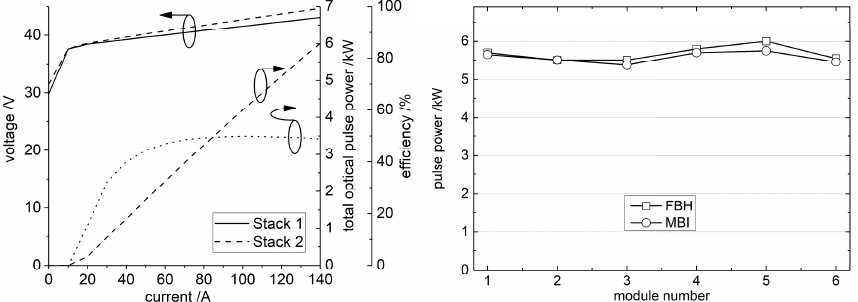
Figure 1. Left : Bias voltage (for the two stacks in a module), optical power and power conversion efficiency as a function of drive current for a Ferdinand-Braun-Institut, Leibniz-Institut für Höchstfrequenztechnik (FBH) pump module ( τ p = 1 ms, f = 100 Hz, FBH data). Right : Ex-fiber operating power as a function of module number for a series of six delivered HEC-DL pump modules ( τ p = 1 ms, f = 100 Hz, FBH and Max-Born-Institut für Nichtlineare Optik und Kurzzeitspektroskopie (MBI) data) [12].